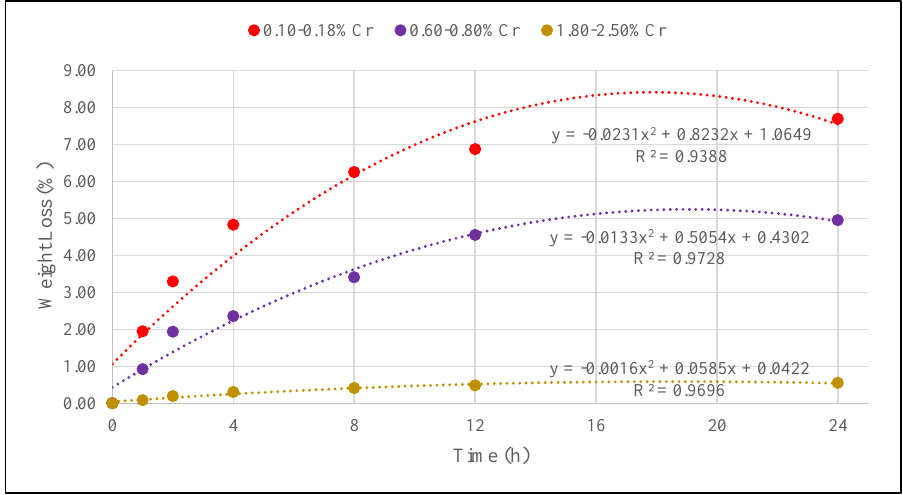
Figure 4. The determination of corrosion rate through the average surface roughness over a period of time.